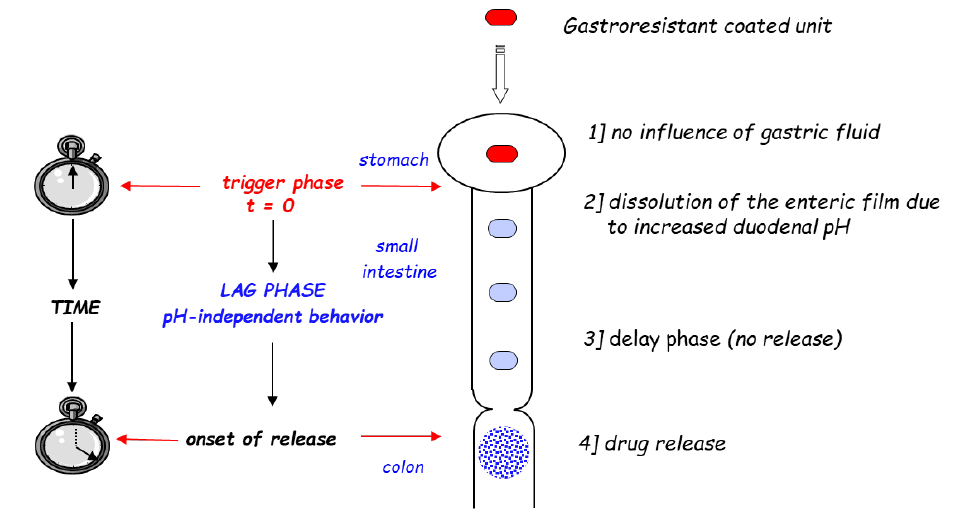
Figure 3. Schematic representation of time-dependent systems for colon drug delivery.